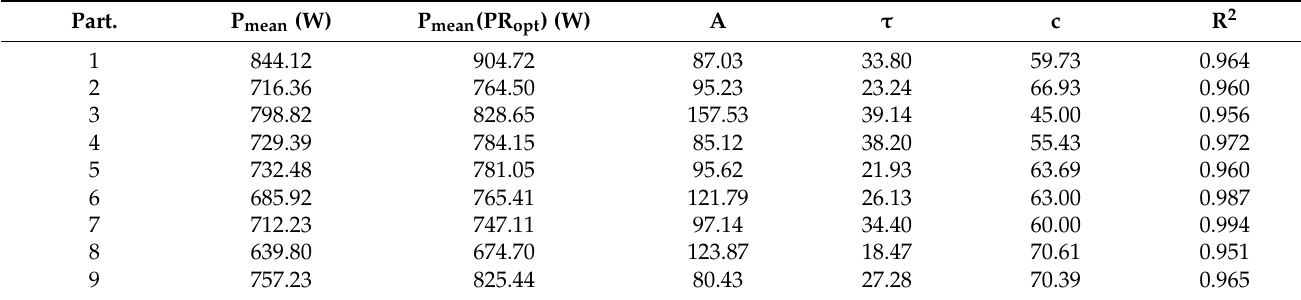
Table 2. Model parameters of the mono-exponential dynamic optimal cadence PR opt (t) with corresponding model quality R 2 as well as mean power output P mean and theoretical mean power output P mean (PR opt ) in the 60-s sprint for all participants. Part.